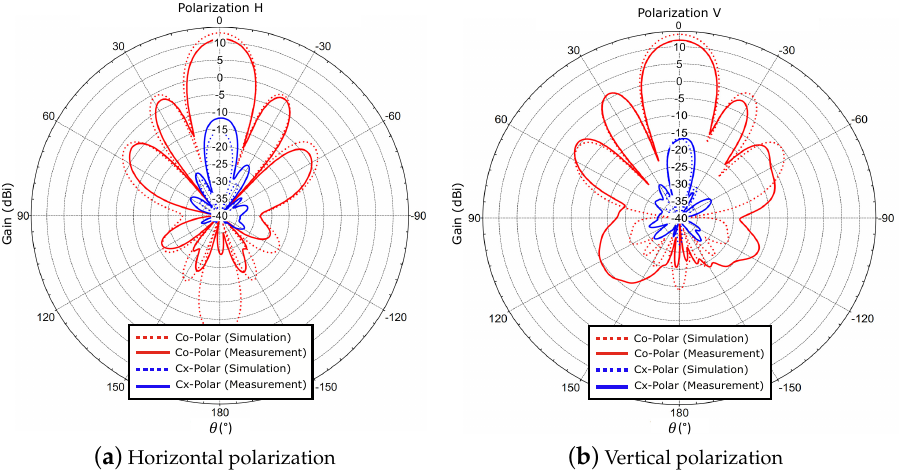
Figure 9. Comparison simulation and measurement @ f 0 = 1.325 GHz: co-polar & cross-polar patterns ( ϕ = 90 ◦ ). Normal array. Uniform amplitude and phase distribution.